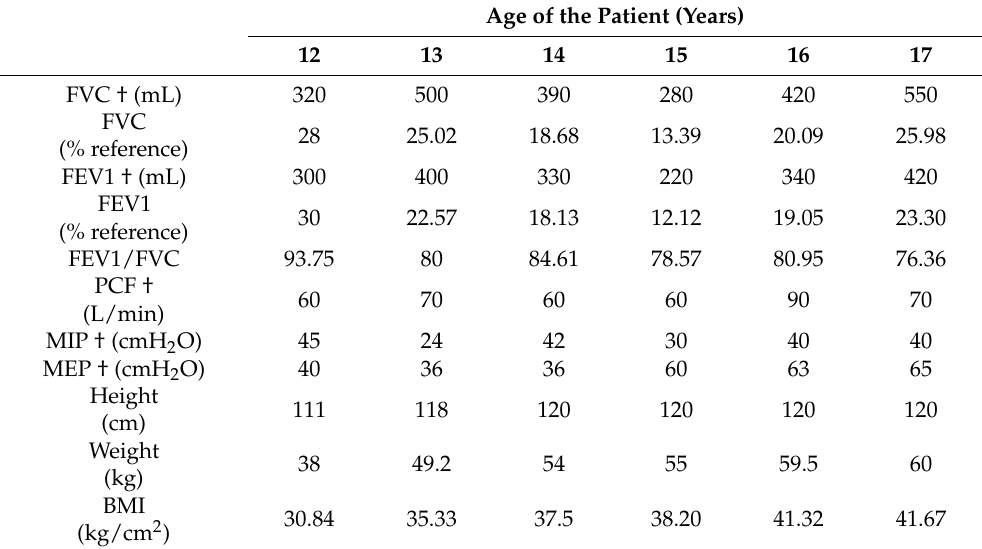
Table 1. Result of annual pulmonary function tests of the patient.